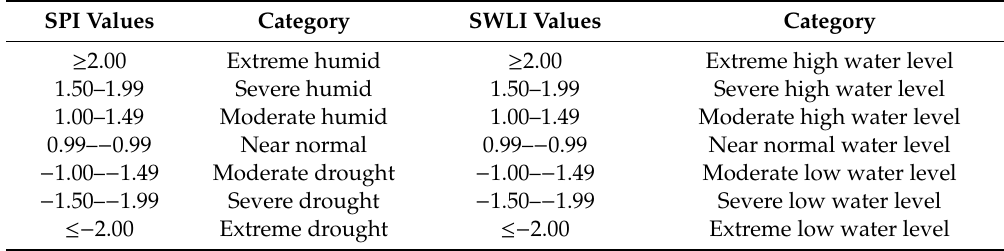
Table 3. Classification of drought and water-level intensities (modified after [24], p. 2; [29], p. 5). SPI Values Category SWLI